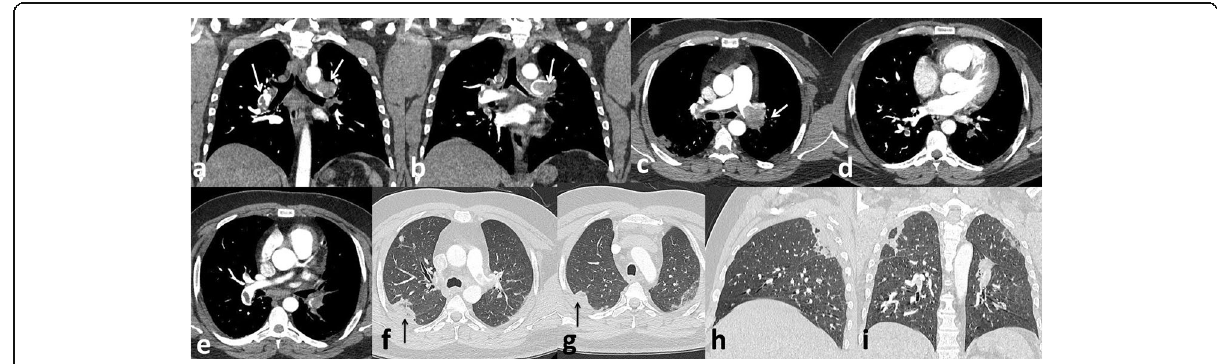
Fig. 7 Male patient 63 years old. Pulmonary embolism at main pulmonary arteries (white arrows in a , b , c ). Peripheral wedge shaped consolidation may represent pulmonary infarction black arrows in ( f and g )